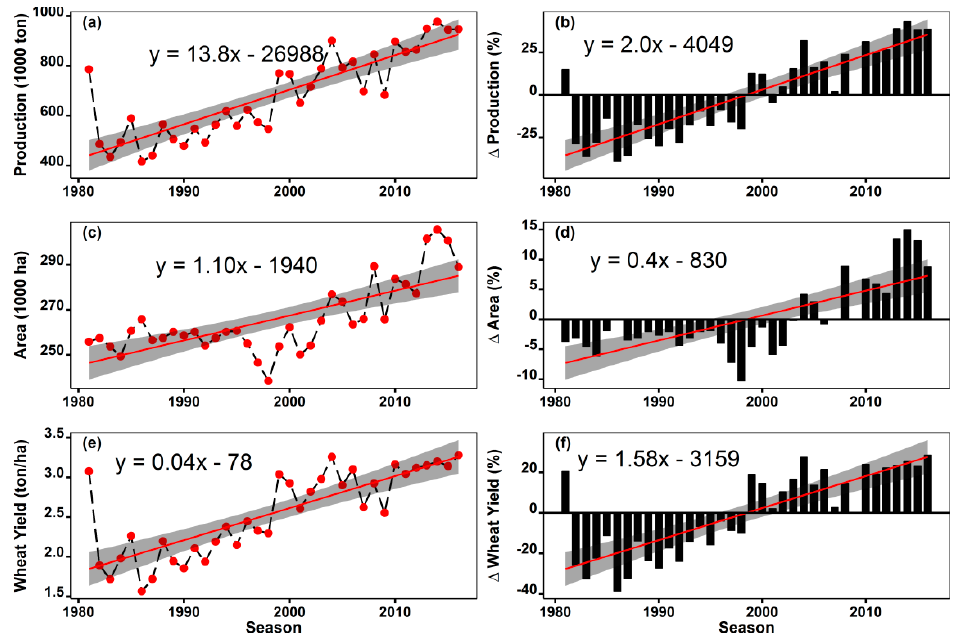
Figure 3. Trends of wheat seasonal average (a) minimum temperature (T min ), (c) maximum temperature (T max ); and seasonal cumulative (e) solar radiation (R n ) and (g) rainfall (P) during 1980– 2017 (left-hand panel). The right-hand panel (Figure 3 b,d,f,h) shows the deviations of T min , T max , R n and P from their respective long-term (1980–2017) averaged values during each wheat season. Red lines in Figure 3a − h show the trends of the climate variables and the grey region represents the 95% confidence interval.